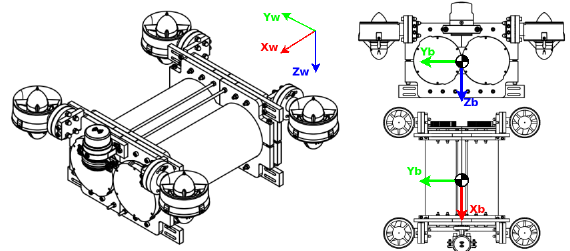
Figure 1. Visualisation of the centre of mass (com) from two different points of view. Subindex ”w” means with respect to the world frame, while subindex ”b” means with respect to the body